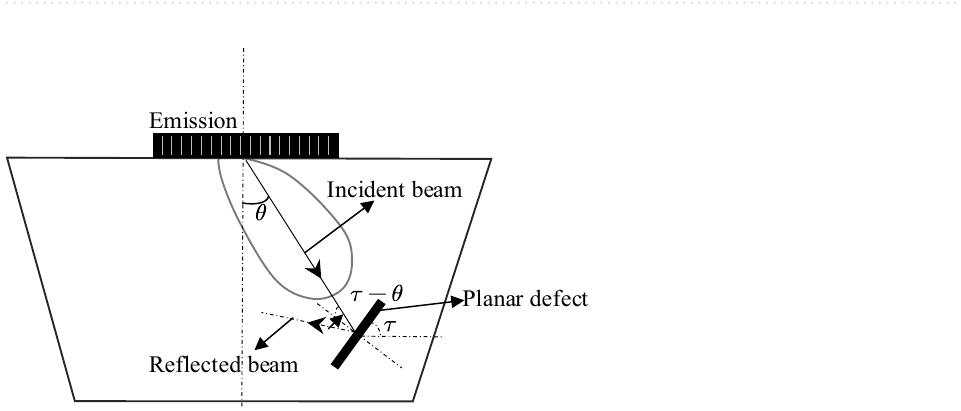
Figure 3. Schematic diagram of acoustic reflection of area defects deviating from the axis of the acoustic